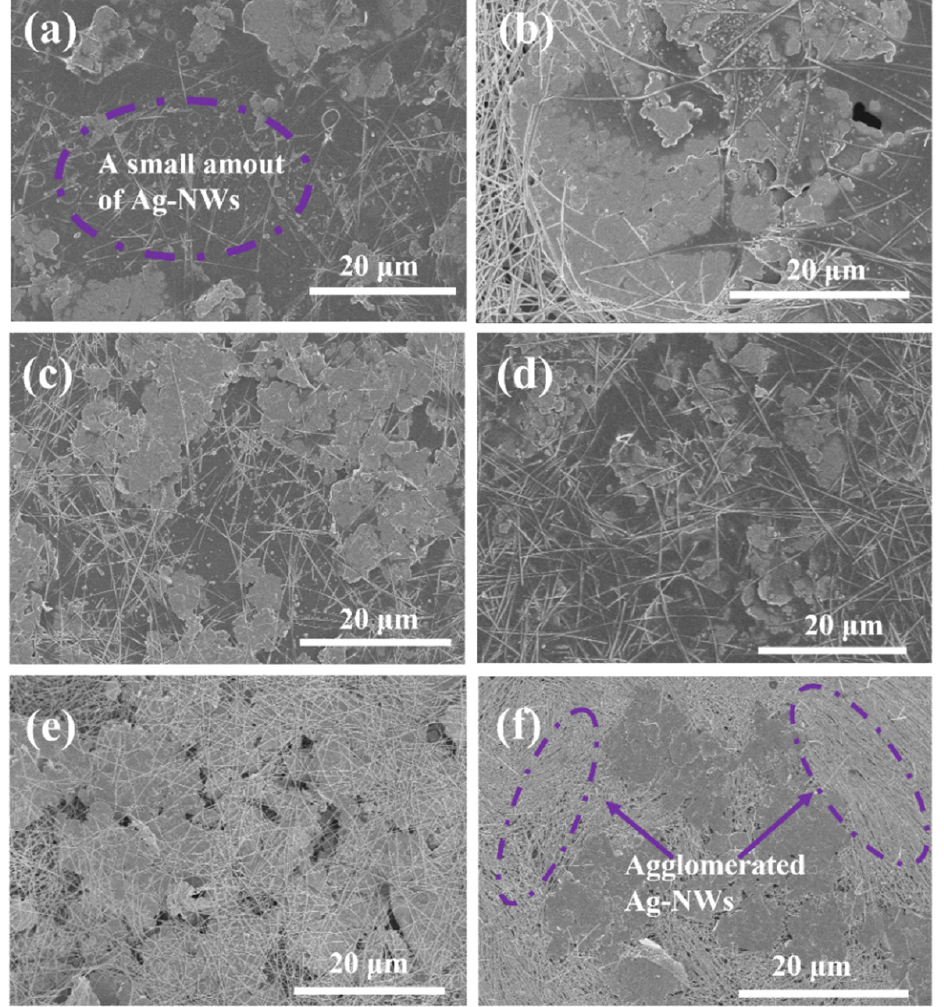
Figure 6. SEM images of silver paste paint films containing different amounts of Ag MFs and Ag NWs after curing at 60 ◦ C: ( a ) F 27.5 W 2.5 , ( b ) F 25.0 W 5.0 , ( c ) F 22.5 W 7.5 , ( d ) F 20.0 W 10.0 , ( e ) F 17.5 W 12.5 , ( f ) F 15.0 W 15.0